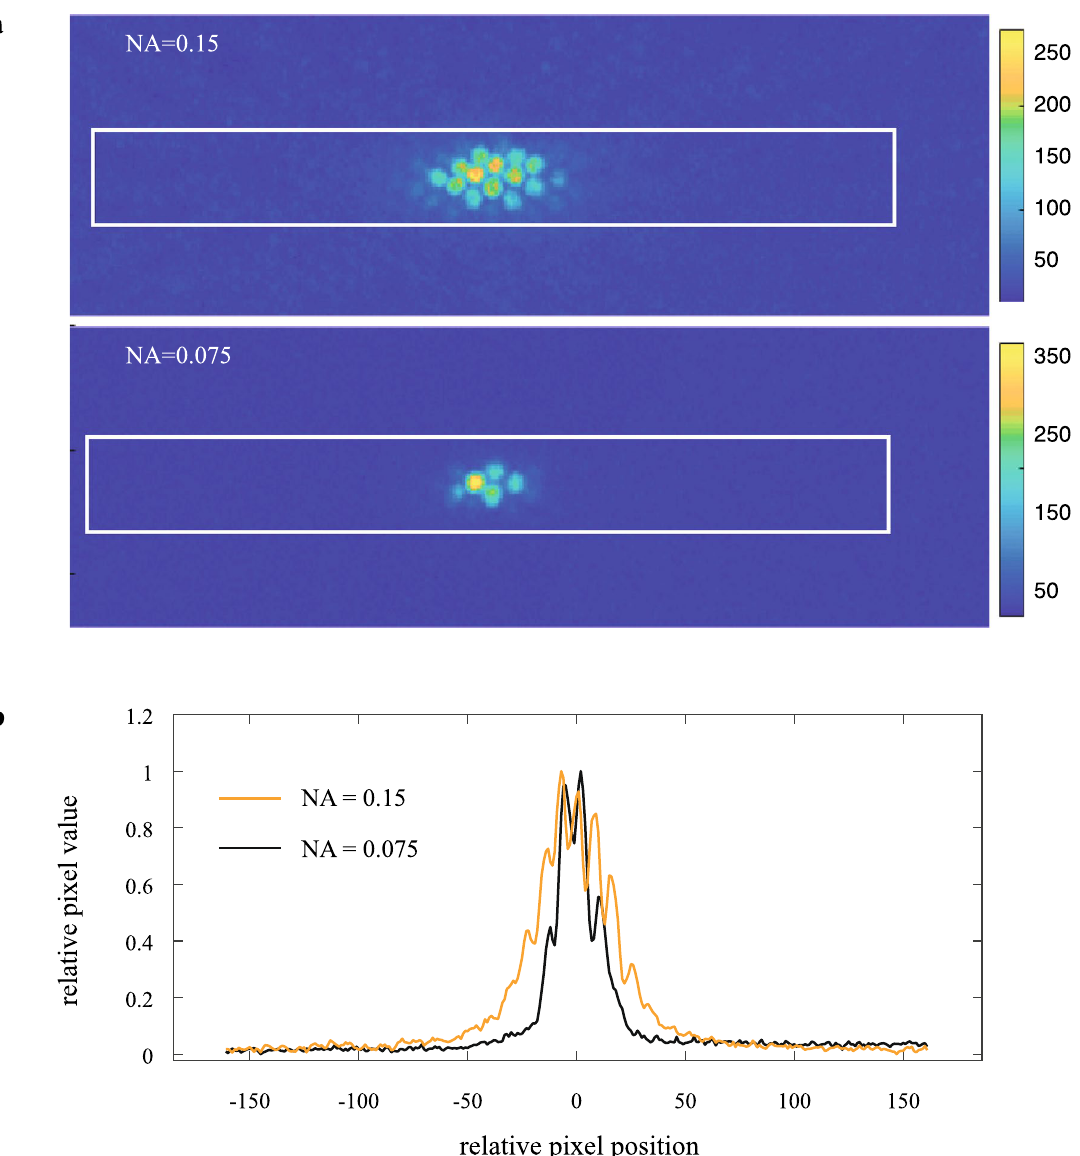
Figure 4. The dimensions of the induced fluorescent pseudopupil depends on the numerical aperture (NA) of the objective lens. (a) Heatmap of the induced fluorescent pseudopupil in a honeybee forager eye stained with Lucifer Yellow (see “Methods”) and acquired with a Nikon SMZ18 microscope fitted with a P2-EFLGFP-B filter cube, a 1 × SHR PlanApo objective with two different numerical apertures (NA), 0.15 ( top ) and 0.075 ( bottom ). (b) Relative pixel values of the rectangular area in (a) showing that the two pseudopupils have the same centre despite subtending a broader area when the NA is higher ( orange line visible. Besides the presence of pigments, other factors may influence the penetration and uptake of the dyes, so future experimenters will need to optimise the dissection and application of the fluorophore for their selected target species. For example, we noticed differences in the rate of uptake depending on whether glands and tra- cheal tubes were removed, as well as how much the sample was subsequently exposed to light. It has previously been reported that light might facilitate and speed up the endocytotic uptake of Lucifer Yellow by photoreceptors when injected through the retina 39 . We certainly observed a large increase in bright- ness of the eye during exposure to light while imaging under the epifluorescence microscope. Thus, in order to acquire images and map the pseudopupil across large areas of the eye it is important to minimize the exposure time, and to minimize the light intensity of both the microscope and the laboratory environment. Note that the dye diffuses throughout the haemolymph and other structures in the eye will also appear fluorescent (e.g. antennal pedicel and ocelli). As we mentioned earlier, if left incubating for a long enough time, even in the dark (from about 3–4 h in the dark at RT for the drone fly Eristalis ), the entire eye will end up glowing (Fig. 2e), frustrating further attempts to image the pseudopupil. We observed this for both Lucifer Yellow and for Neurobiotin 488. In future it may